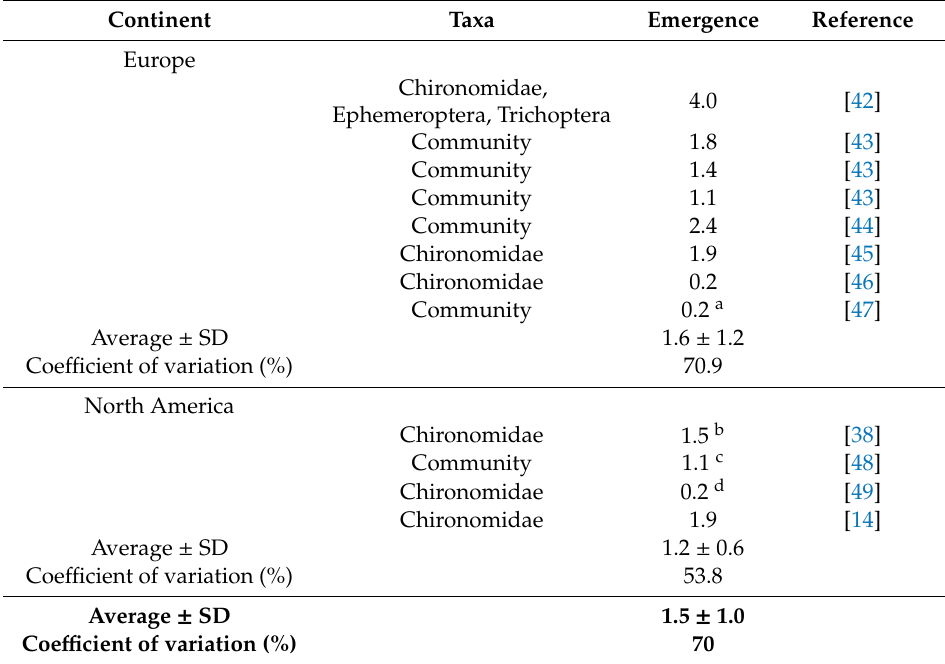
a average values calculated from Table 3 of the reference. b averaged author (cid:48) s data. c Recalculated from authors data. d average value calculated from Table 2 of the